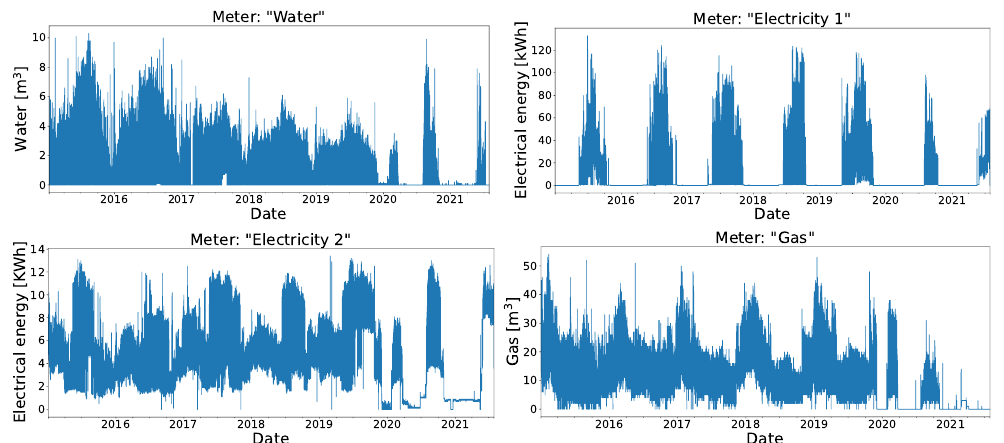
Figure 13. Representation of corrected time series, associated with the different hotel meters.